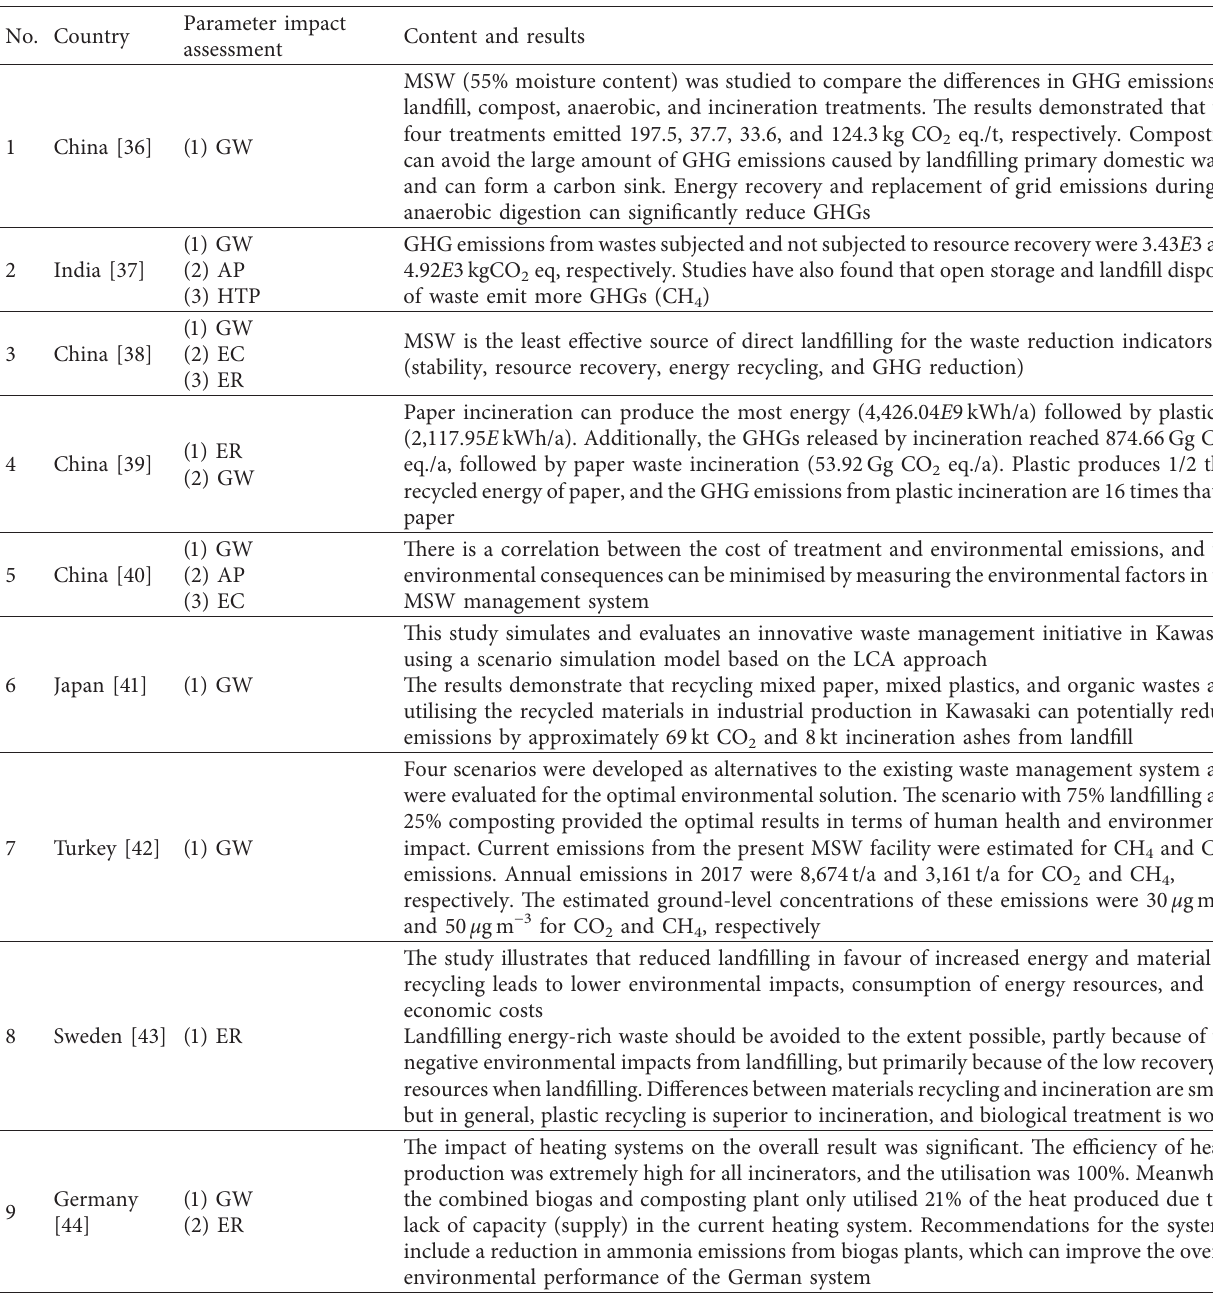
Table 3: Summary of major MSW management LCA